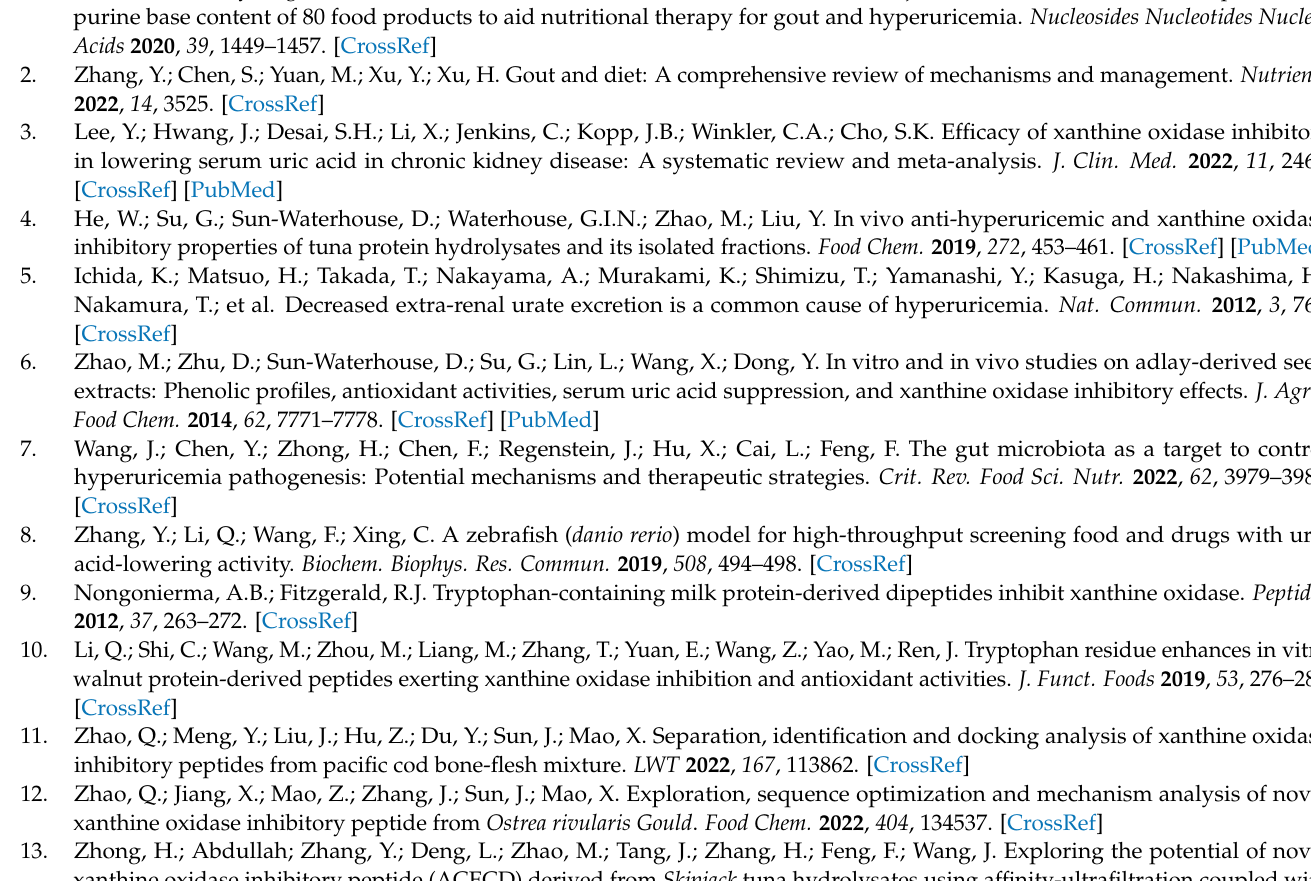
table of small yellow croaker hydrolysates MW distributions; Table S2: Relative peak table of peptides molecular weight less than 3 kDa MW